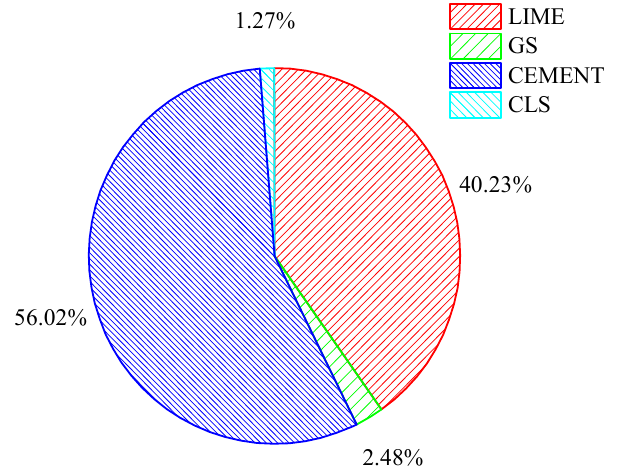
Figure 19. Comparative savings in carbon energy with traditional stabilizers.